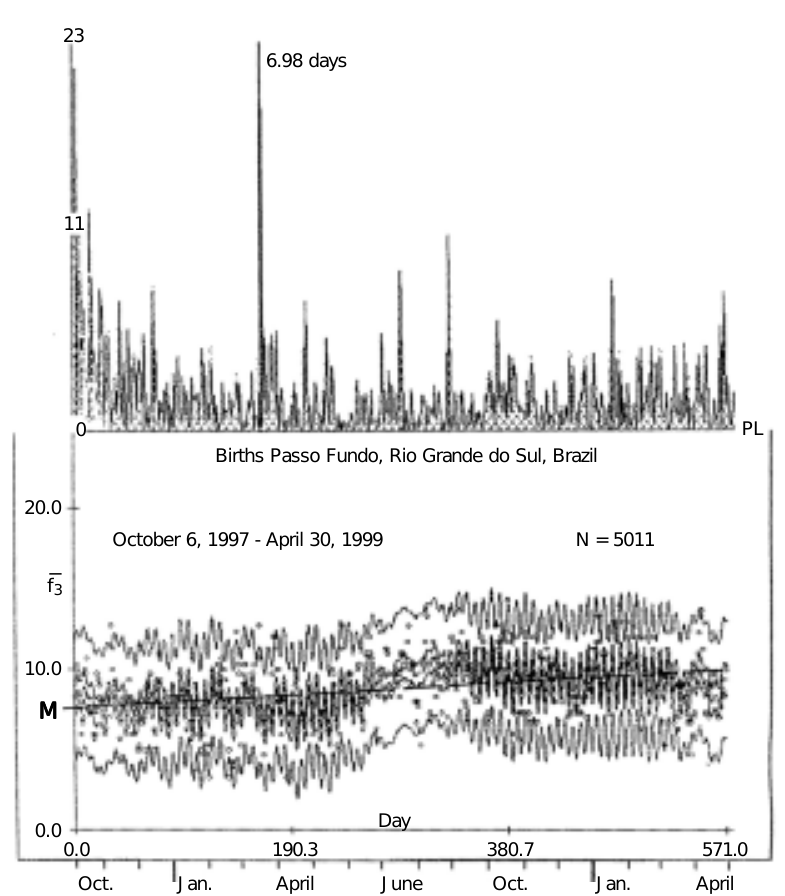
Figure 2. Top , Periodogram with the relative measure of significance (ordinate) versus period length (PL). Bottom , The chronogram of the daily birth numbers. Data are presented as open dots; the approximating regression function is accompanied by the limits of 95% confidence interval (for means, narrow) and tolerance (for separate data, wide). The very narrow confidence corridor results together with the central point estimate of the function into one heavy line. M = mesor as the starting value of the linear trend